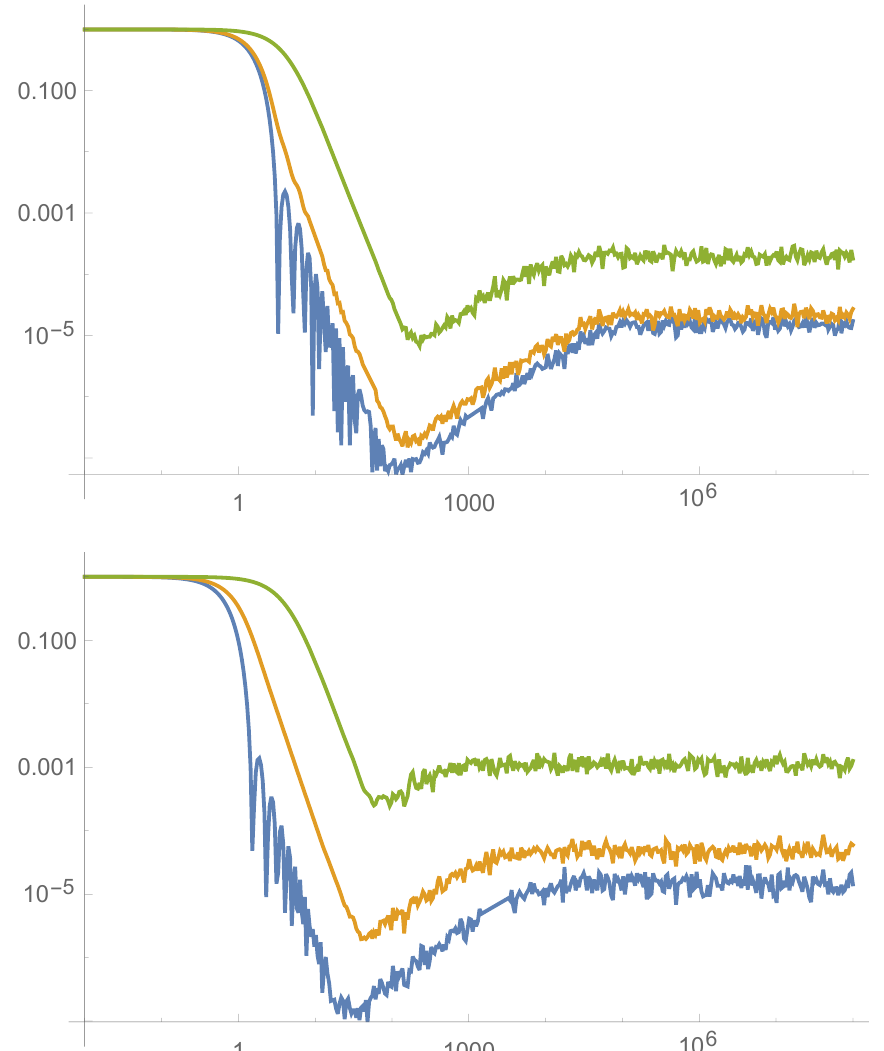
Figure 6 . Top: the SFFs for the SYK model at (cid:12) = 0 (blue line), (cid:12) = 1 (yellow line) and (cid:12) = 5 (green line). Bottom: the SFFs for the generalized SYK model at (cid:12) = 0 (blue line), (cid:12) = 1 (yellow line) and (cid:12) = 5 (green